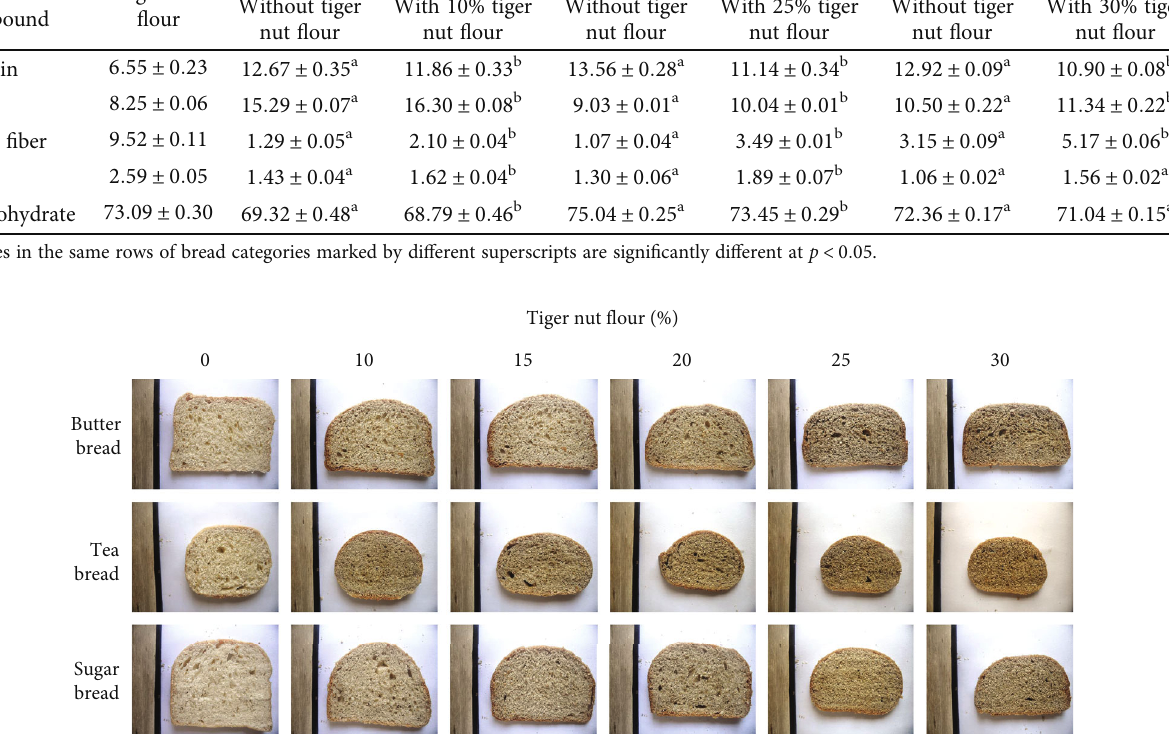
Table 2: E ff ects of substituting wheat fl our with tiger nut fl our on butter bread, tea bread, and sugar bread on the nutrient composition (g/100 g). Nutrient compound